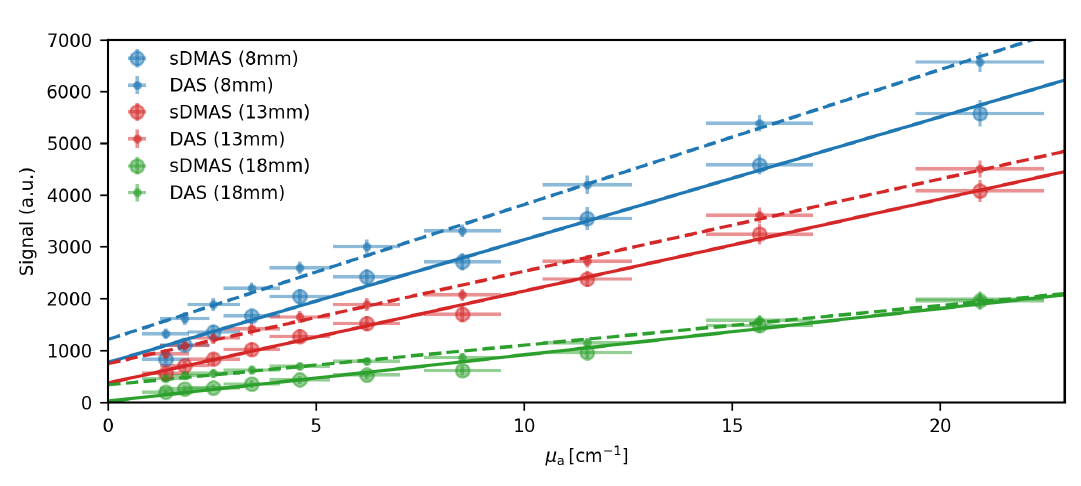
Figure 4. Comparison of the signal intensities dependence on the absorption coefficient. The maximum signal intensities in B-Mode images beamformed with DAS and sDMAS using boxcar apodization are averaged over n = 100 images for three sources. Linear fits are plotted alongside with the measured data. Both DAS and sDMAS have a proportional relation to the sources absorption coefficient when accounting for an additive noise